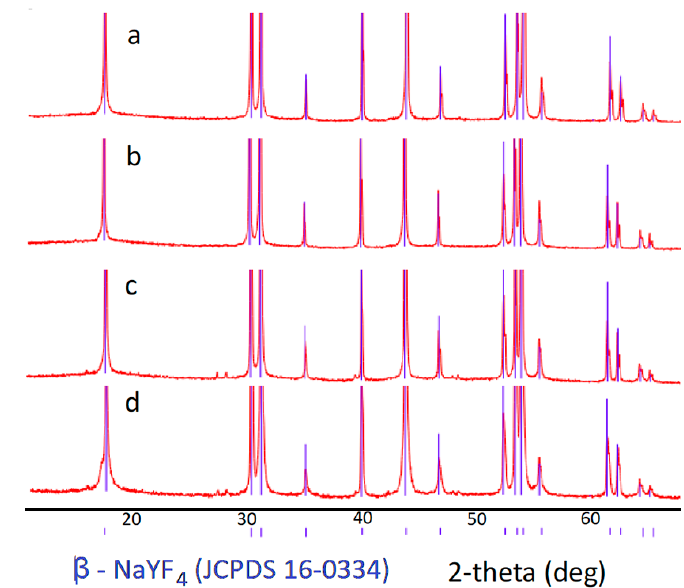
Figure 1. XRD patterns of the samples: ( a ) 𝛽 -NaYF 4 : 20% Yb, 1% Tm, ( b ) 𝛽 -NaYF 4 : 20%Yb, 1% Er, ( c ) 𝛽 -NaYF 4 : 20% Yb, 1% Tm, 5% Gd, and ( d ) 𝛽 -NaYF 4 : 20% Yb, 1% Er, 5% Gd. Blue lines show standard values for pure hexagonal 𝛽 -NaYF 4 .